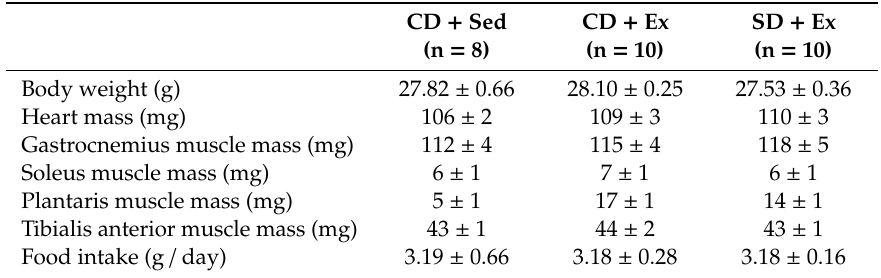
Table 1. Values are means ± SEM. CD + Sed: control diet + sedentary group, CD + Ex: control diet + exercise group, SD + Ex: Sparassis crispa diet + exercise group.